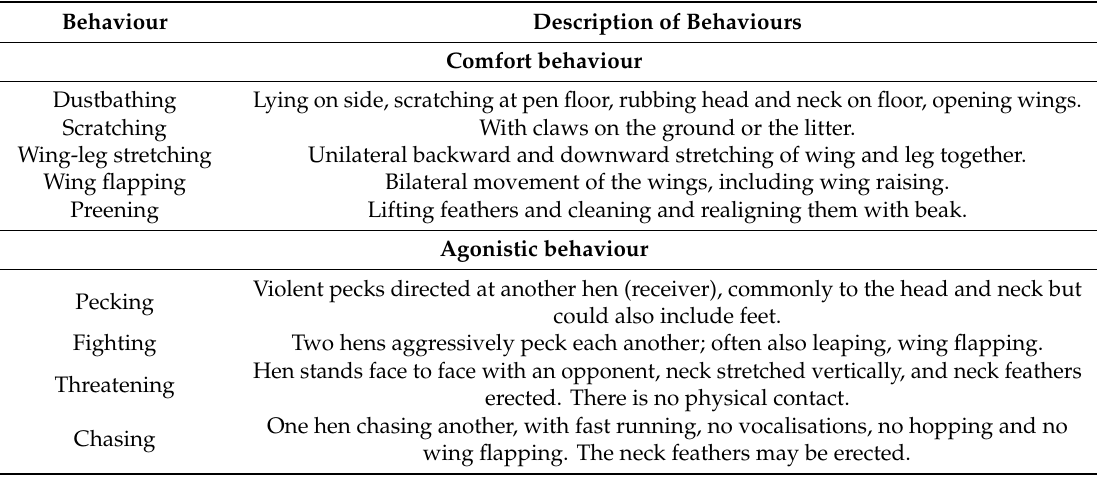
Table 1. Behavioural categories and